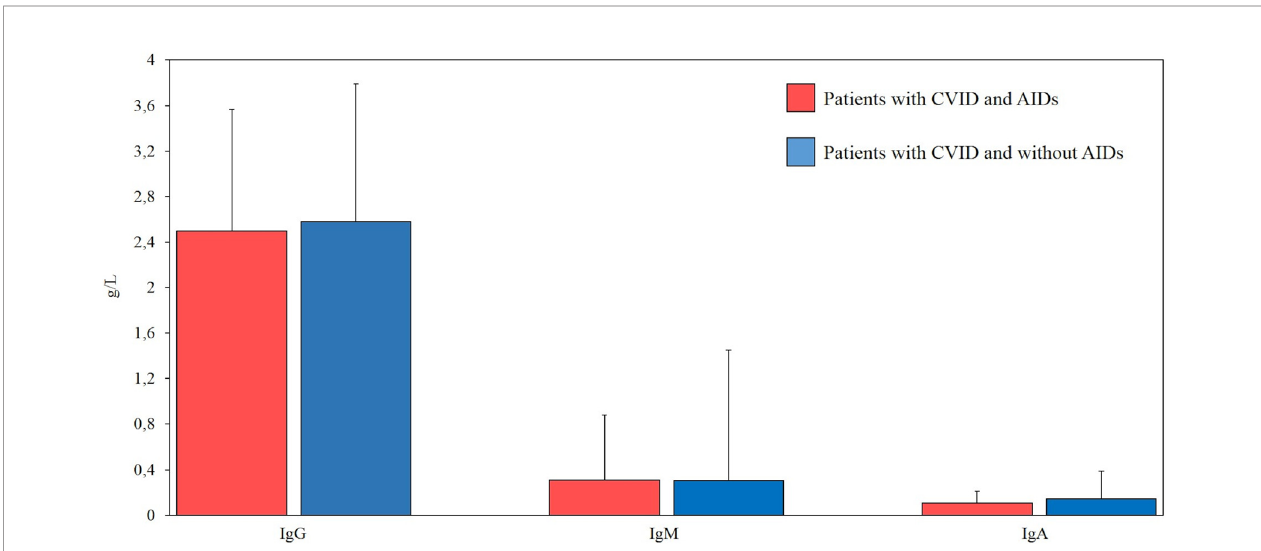
FIGURE 1 | Comparison between serum levels of immunoglobulins (g/L) at diagnosis in our cohort of patients with common variable immunode fi ciency (CVID) and autoimmune diseases (AIDs) (red bar, n=39) and CVID without AIDs (blue bar, n=56). Normal ranges (g/l) for IgG (7.37-16.07), IgM (0.40-2.30), IgA